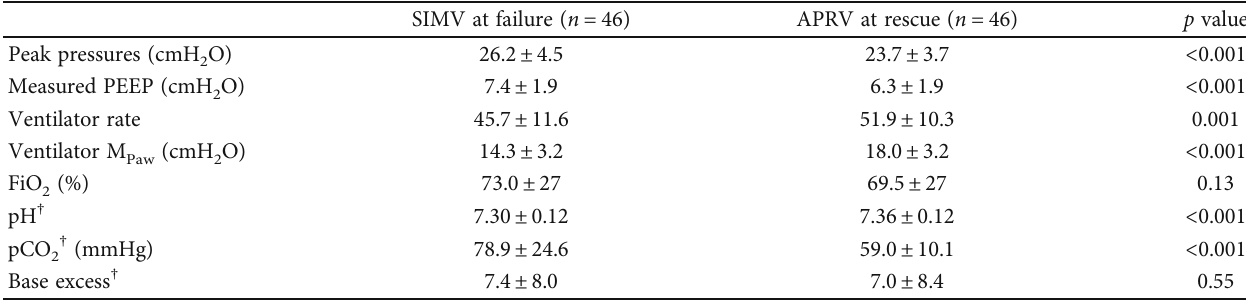
Figure 1: (a) Decrease in peak pressures with use of airway pressure release ventilation (APRV) for rescue, following failure on synchronized intermittent mandatory ventilation (SIMV). (b) Associated increase in mean airway pressures with APRV as compared to SIMV. Closed circles to the left represent SIMV and to the right represent APRV. Transparent gray lines represent individual patients. Solid black line represents mean. Table 1: Infants failing SIMV rescued with